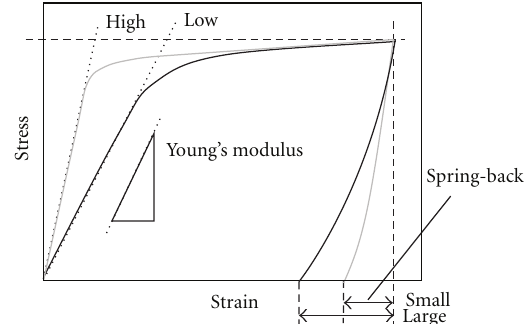
Figure 11: Schematic explanation of relationship between Young’s modulus and spring